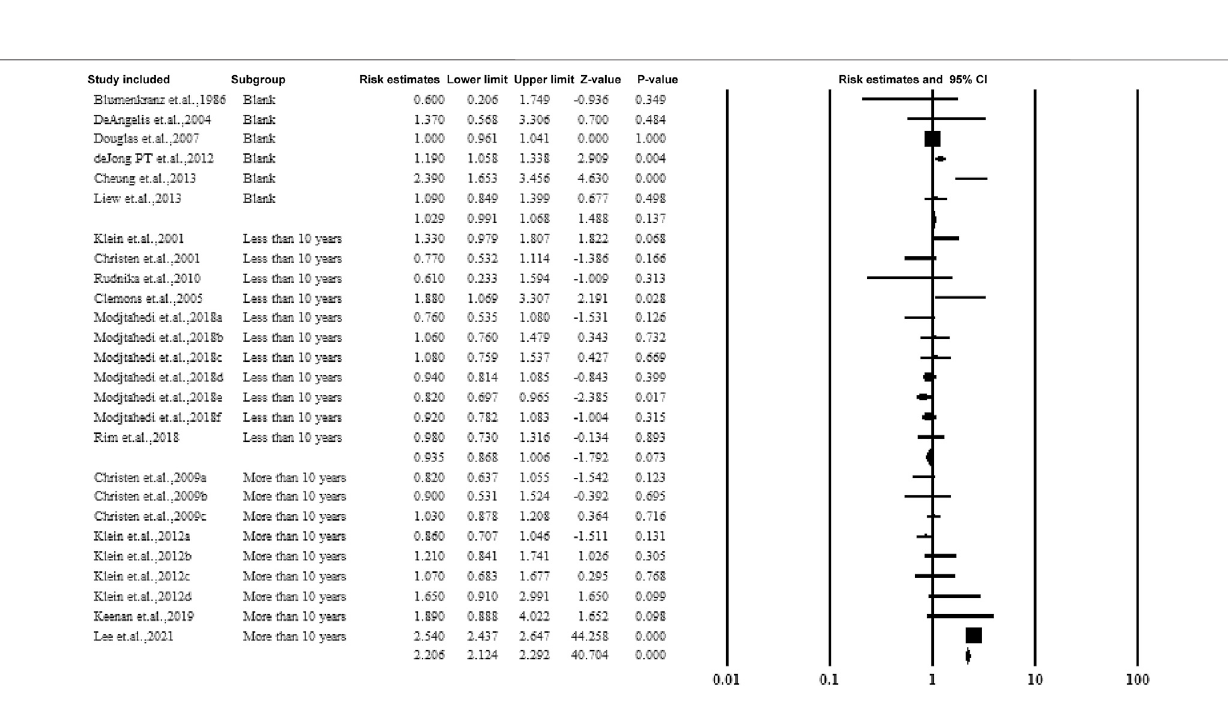
Frontiers in Pharmacology |